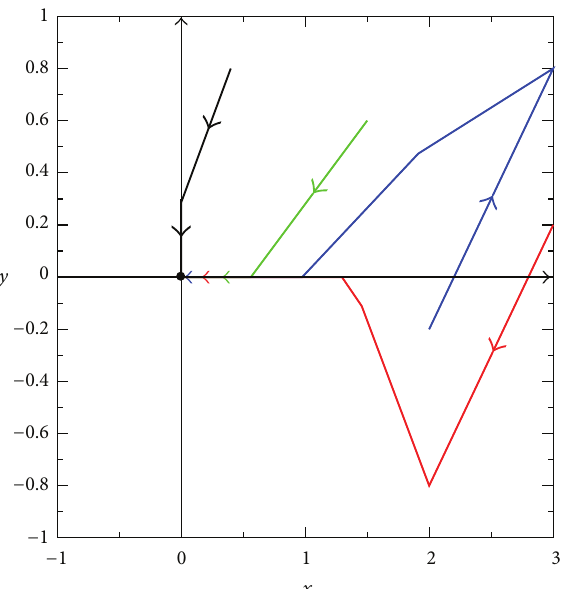
Figure 1: Dynamical behavior of (26) where initial conditions are chosen as (𝜃 + 3,𝜃 + 0.8) , (−𝜃 + 2, −𝜃 − 0.8) , (0.4, 0.8) , and (1.5, 0.6) for 𝜃 ∈ [−1,0] , and the parameters are fixed as 𝑎 = 2 and 𝑏 = 1 .